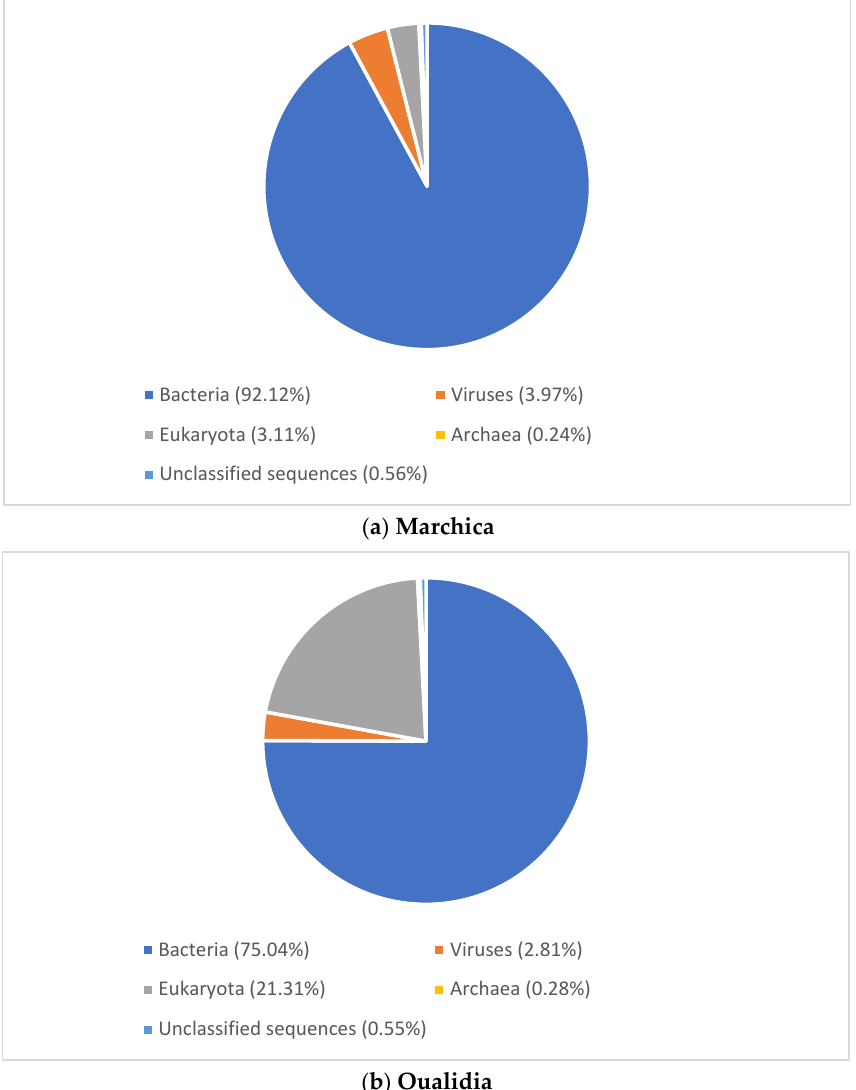
Figure 3. Domain level classification of all metagenomic reads using MG-RAST [23]. ( a ) Marchica lagoon ( b ) Oualidia lagoon.